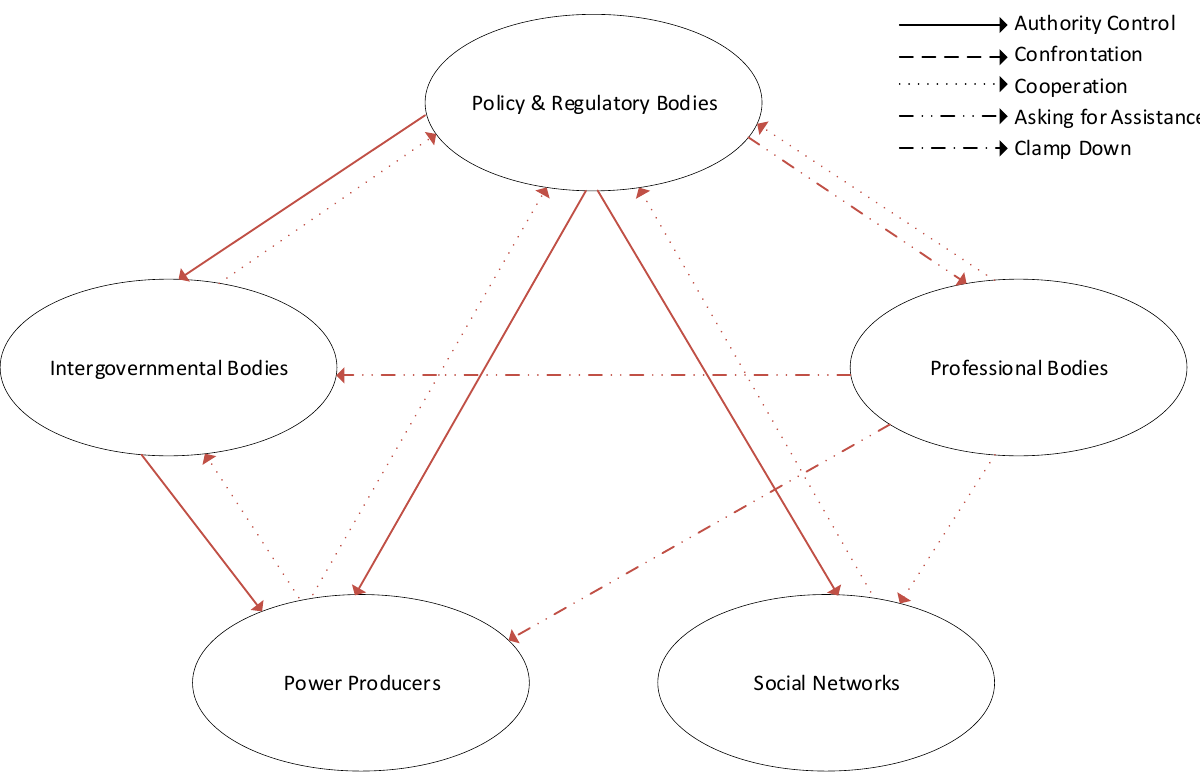
Figure 7. RPS–PNT agenda setting interaction phase